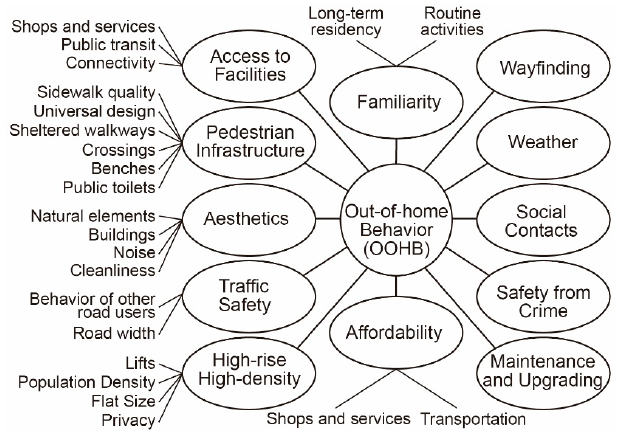
Figure 3. Categories and sub-categories of neighborhood environmental factors influencing older adults’ out-of-home behaviors (OOHBs).